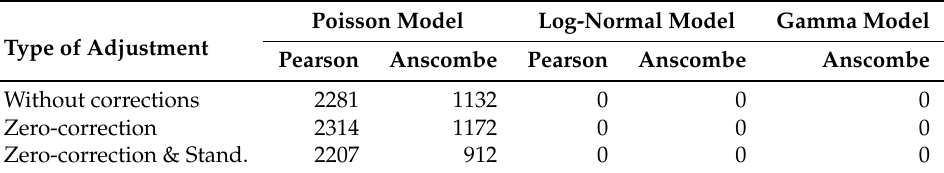
Table 8. Amount of negative values appearing in the pseudo-data during 1000 iterations.